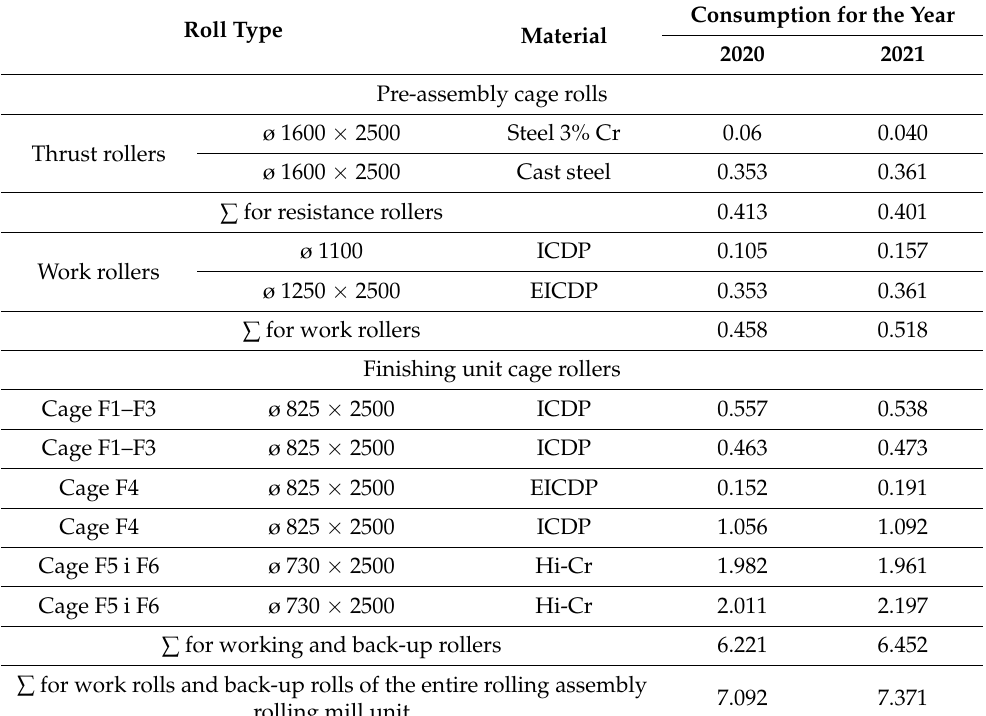
Table 3. Roll consumption rates for 2020 and 2021.